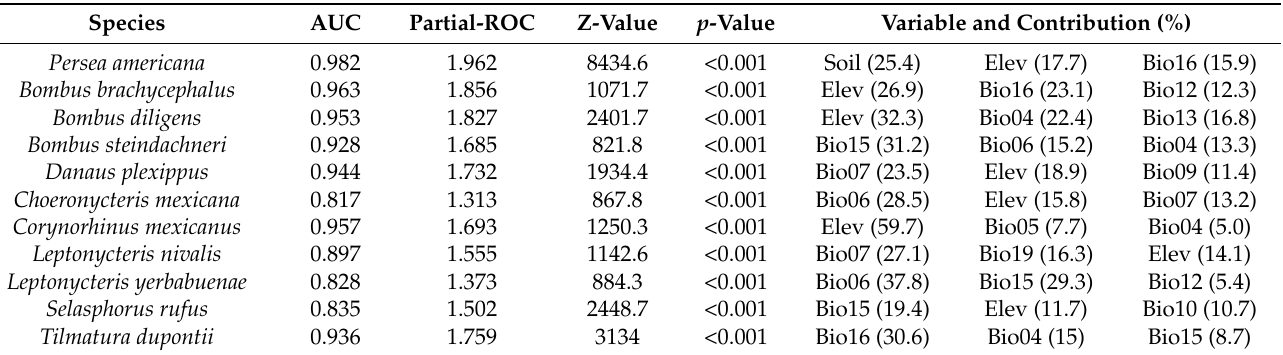
Table 3. Descriptors of the species distribution modeling and contribution percentage of the three most relevant environmental variables in the potential distribution of Persea americana Mill. and ten threatened pollinator species in